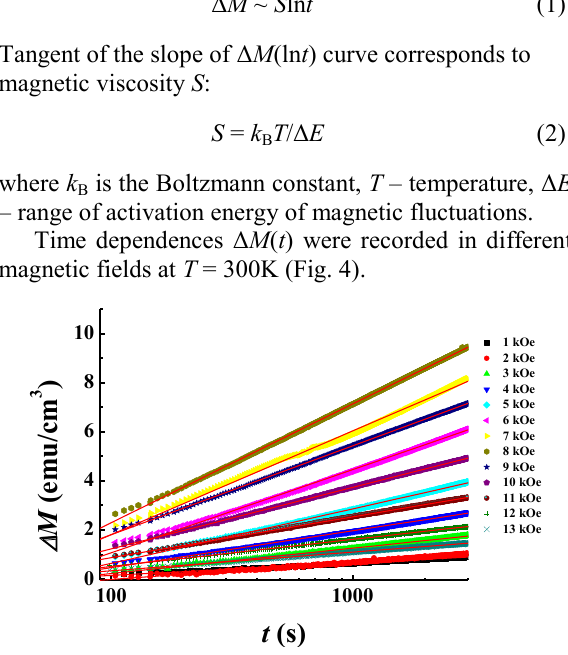
Fig. 4. Time dependences of magnetic moment Δ M ( t ) at T = 300 K in different magnetic fields. Solid lines show approximations.